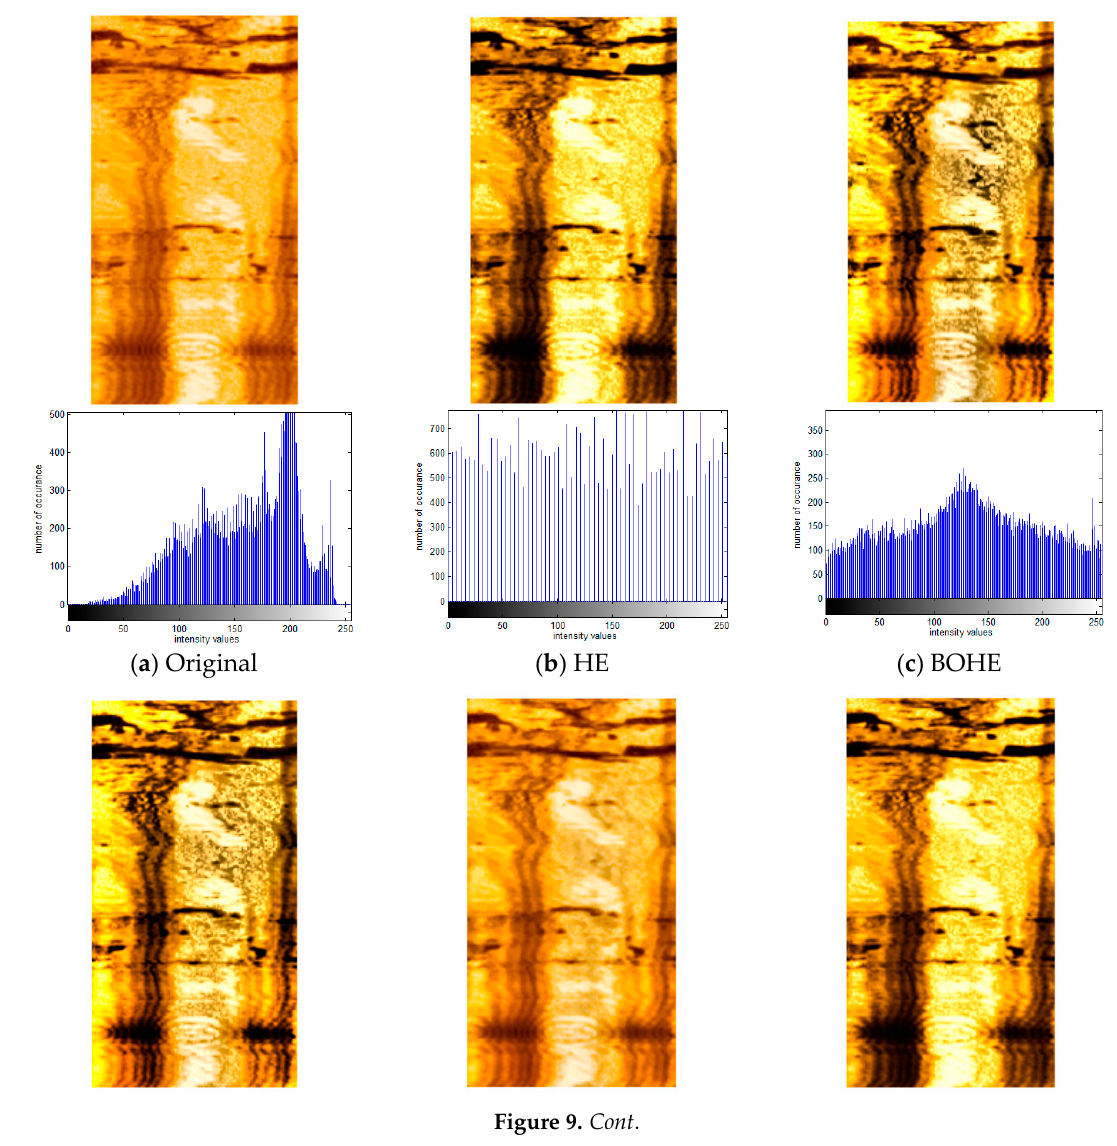
Figure 8. Comparison of enhancement results with corresponding statistical histogram using various techniques for ultrasonic logging image of Changqingyi well. ( a ) Original image; ( b ) HE; ( c ) BOHE; ( d ) POSHE; ( e ) MLBOHE; ( f ) BBHE; ( g ) RMSHE; ( h ) CLAHE-PL; ( i ) Proposed